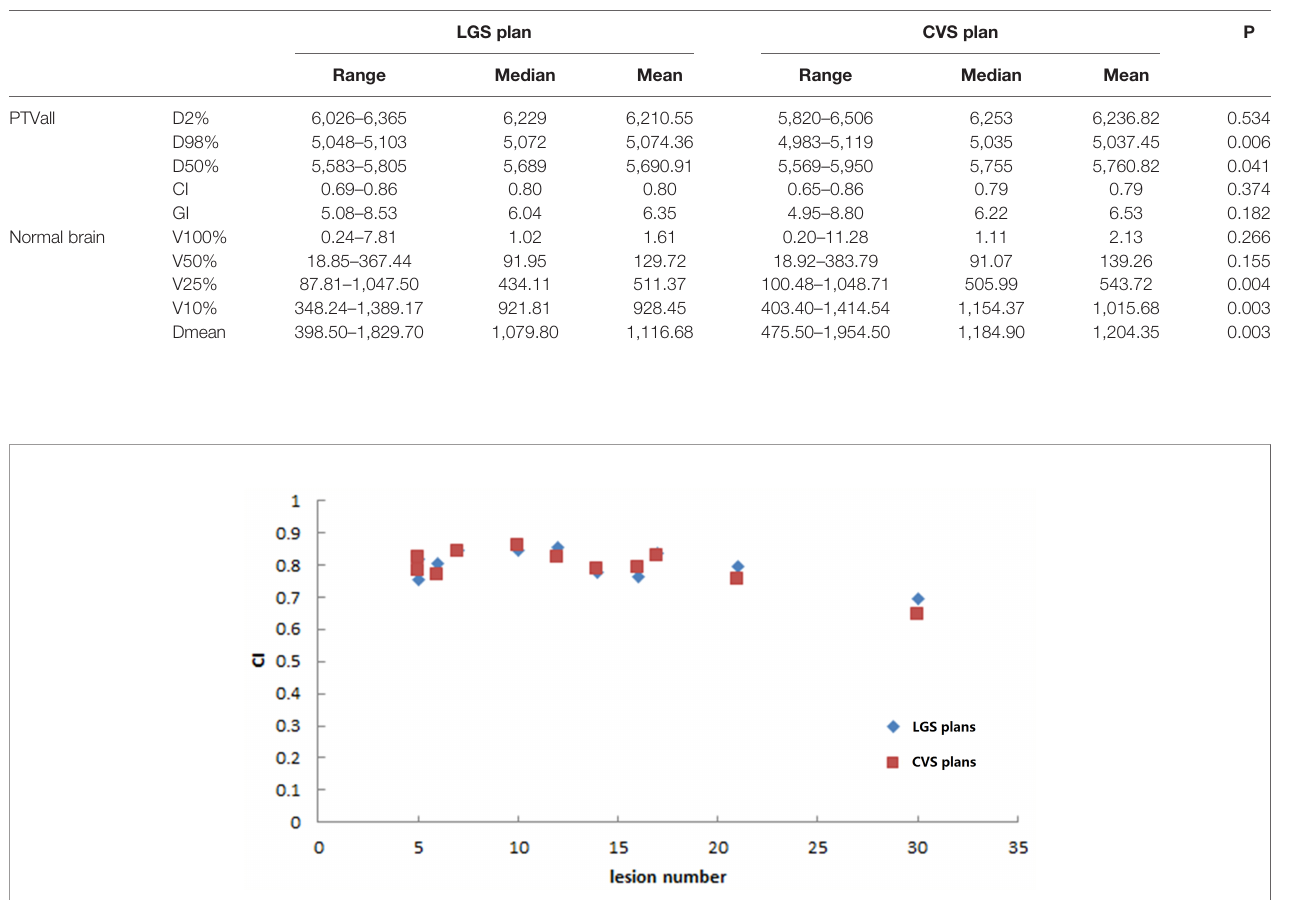
TABLE 1 | Statistics of plan evaluation parameters for the two plan types.